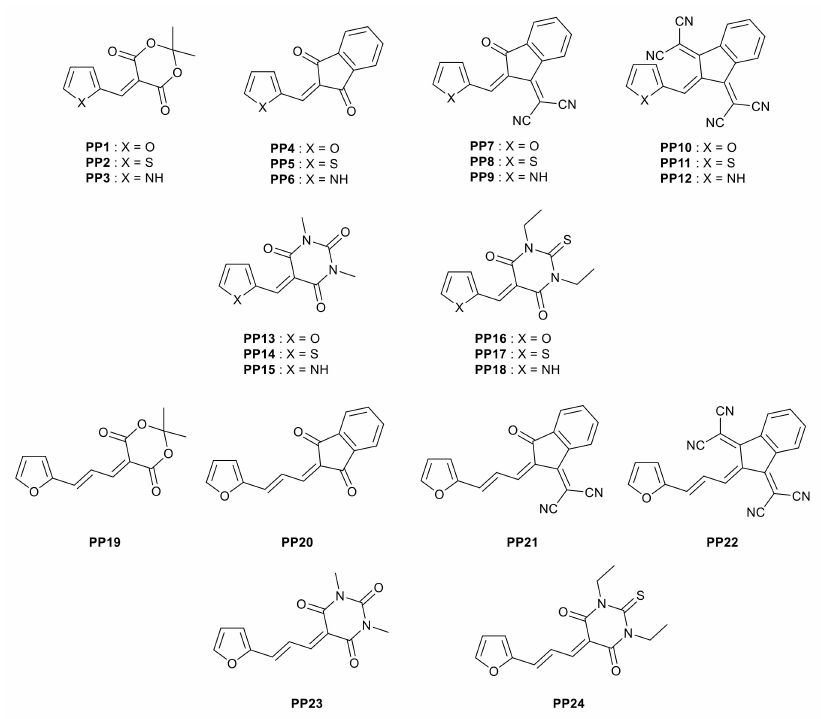
Figure 1. Chemical structures of PP1 – PP24 used as precursors for the design of Donor–acceptor Stenhouse adducts (DASA)